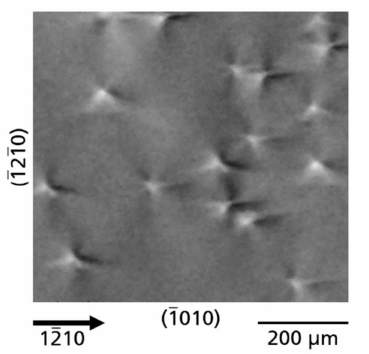
Figure 4. Topograph showing rosette contrasts of TDs with different directions of the bright-dark contrast lobes, indicating different types of TDs (1210